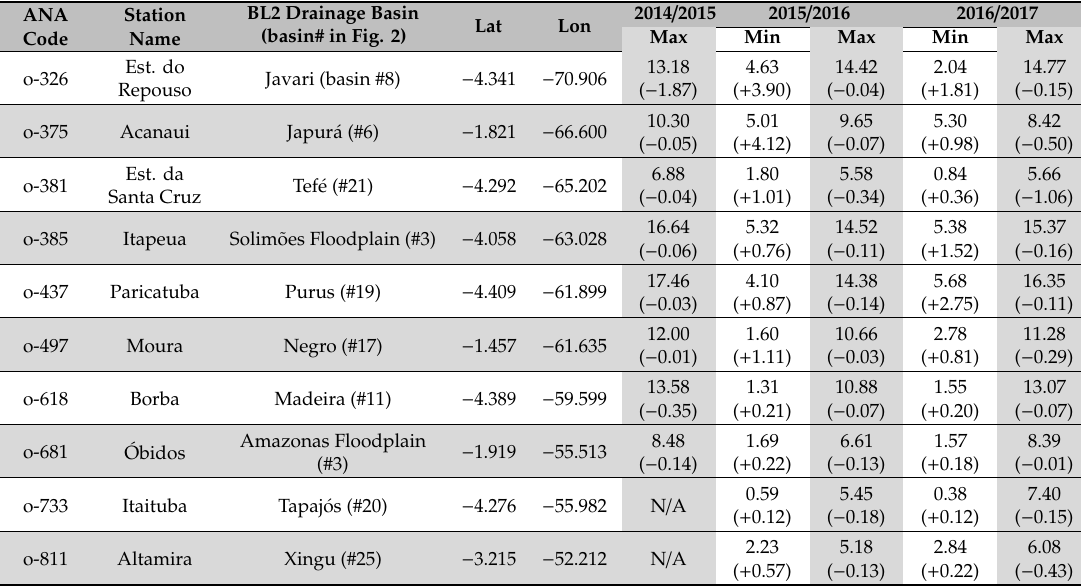
Table 1. River height gauging stations used to assess ScanSAR data representations of annual maximum and minimum flooding conditions across the basin. Values indicate the highest and lowest annual river stages recorded during the ALOS-2 PALSAR-2 acquisitions. Figures in brackets indicate the di ff erence corresponding to the station maximum or minimum stage that same hydrological year. All values are in meters (Source: Ag ê ncia Nacional de Á guas,